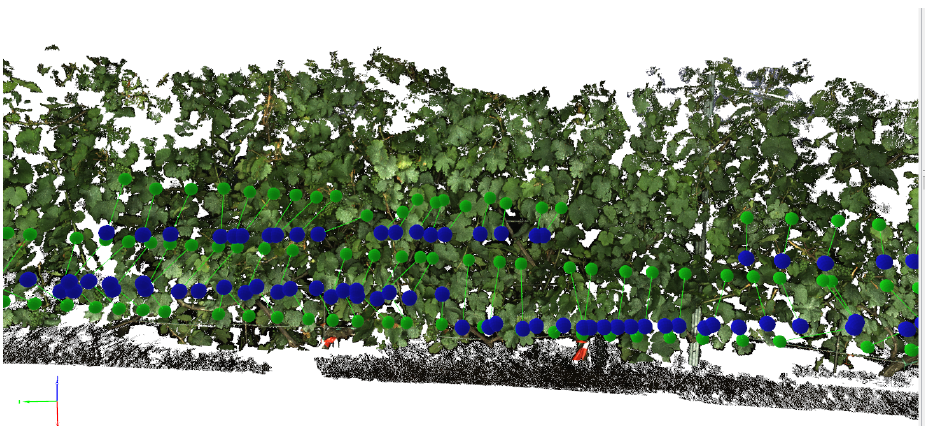
Figure 6. Part of the reconstructed SMPH grapevine row (25 m). The dark background is clearly visible. Blue spheres indicate initial GPS positions of the cameras. Green spheres indicate final camera positions corrected during bundle